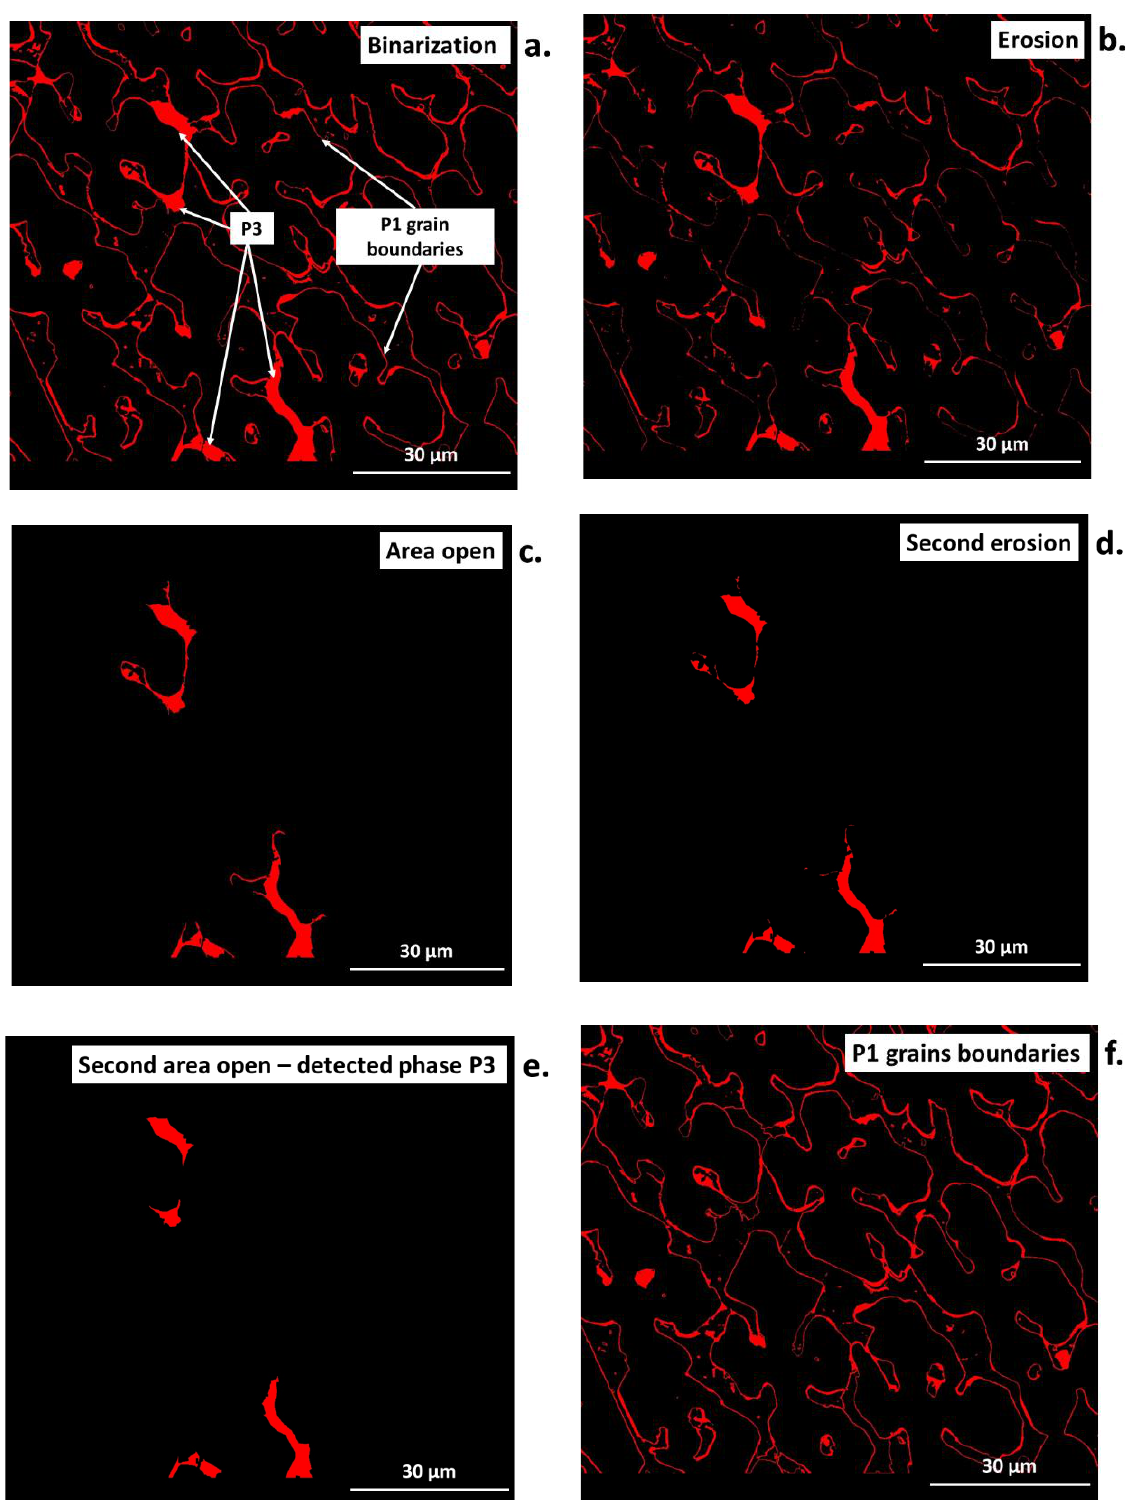
Figure 20. SEM image during automated analysis for P3 phase: ( a ) after thresholding, ( b ) after thresholding followed by morphological transformations (c-f).